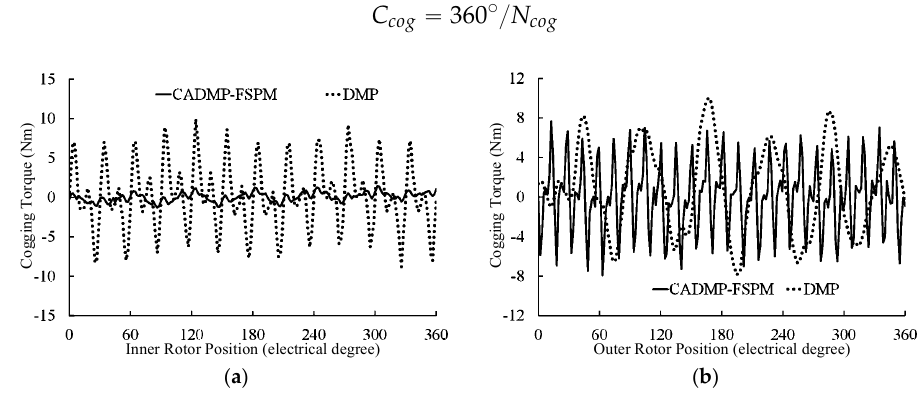
Figure 8. Cogging torque waveforms of two machines. ( a ) Inner machines; ( b ) Outer machines.